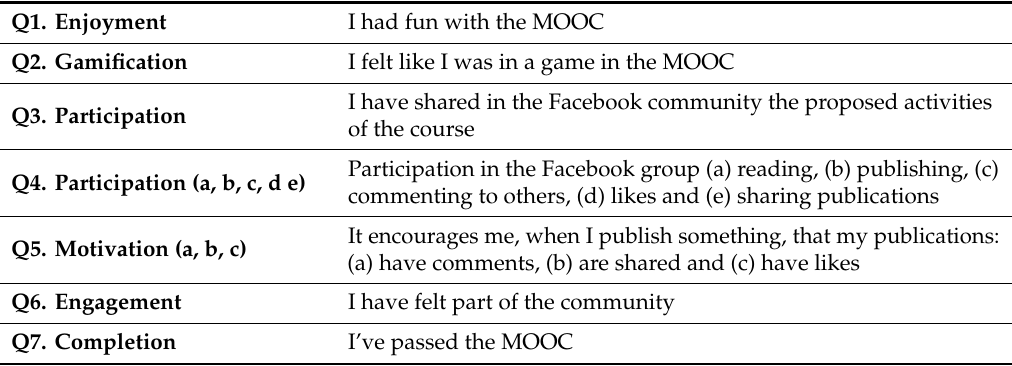
Table 4. Selected questions from the satisfaction survey for the study.